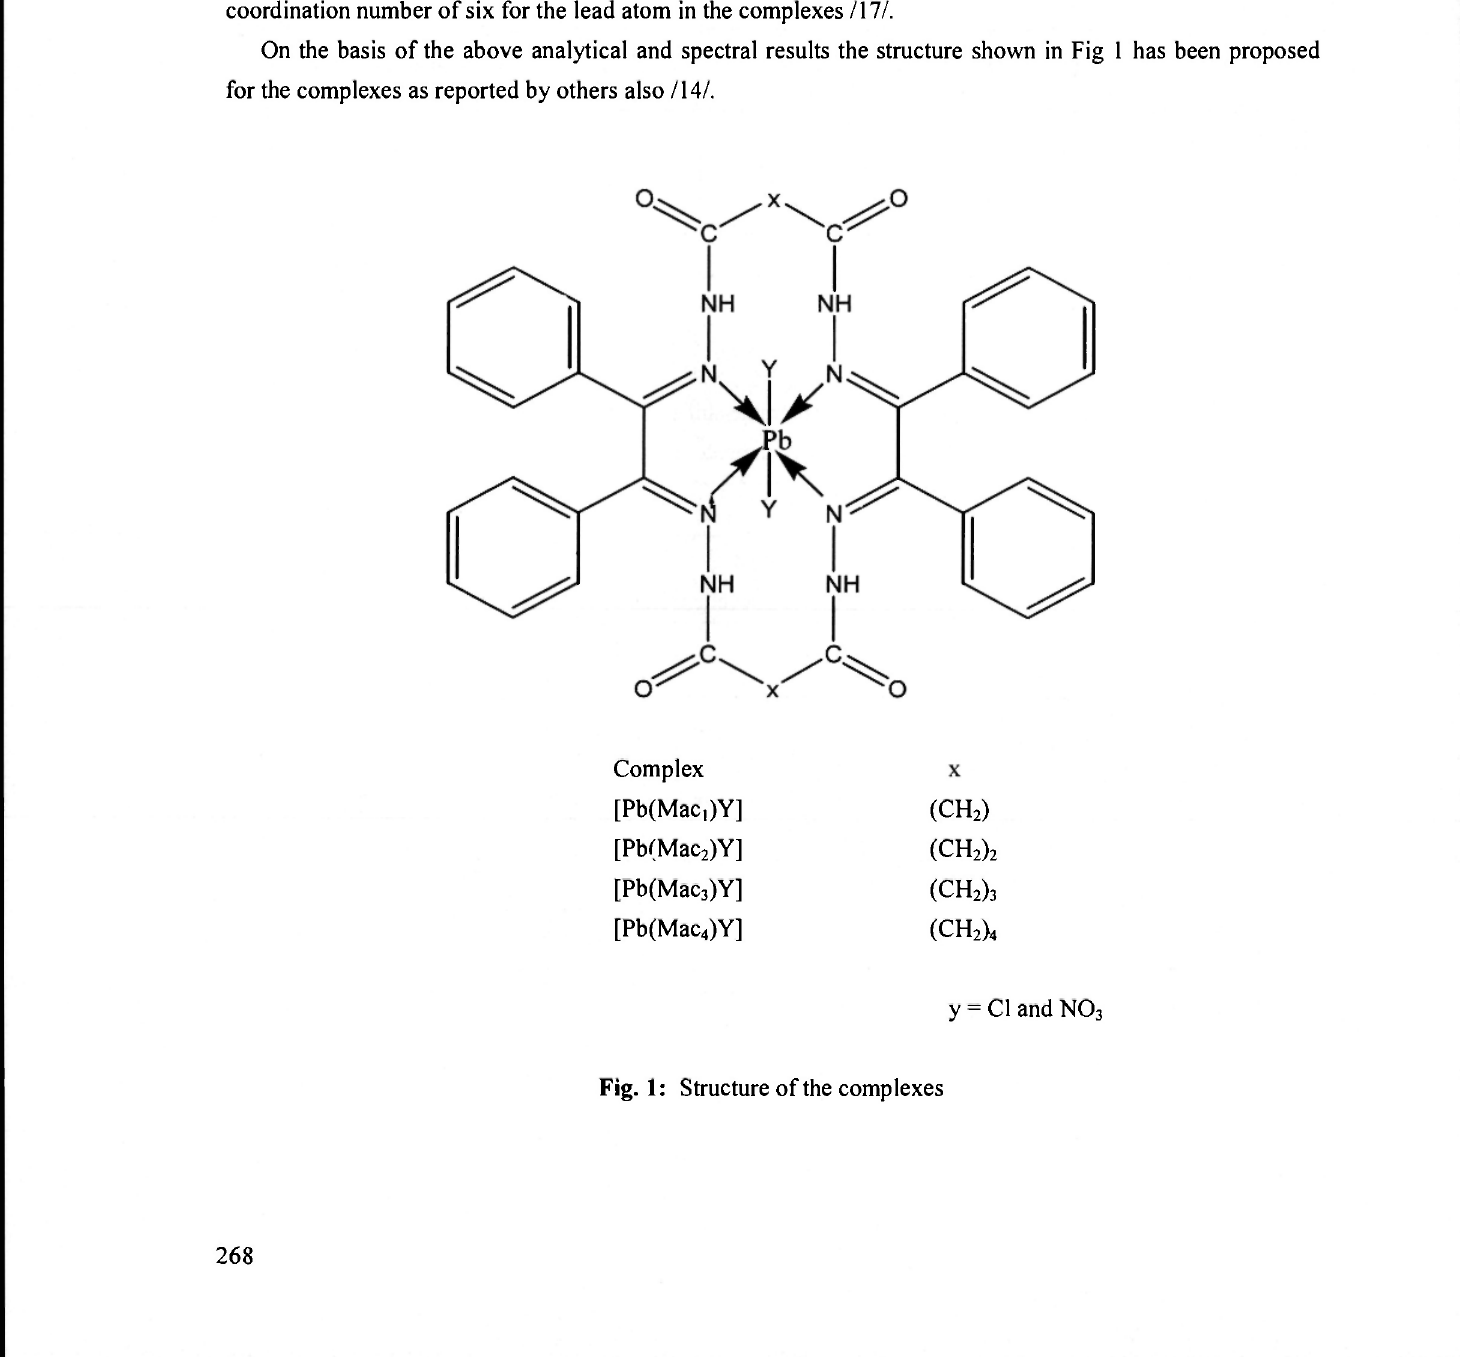
Fig. 1 : Structure of the